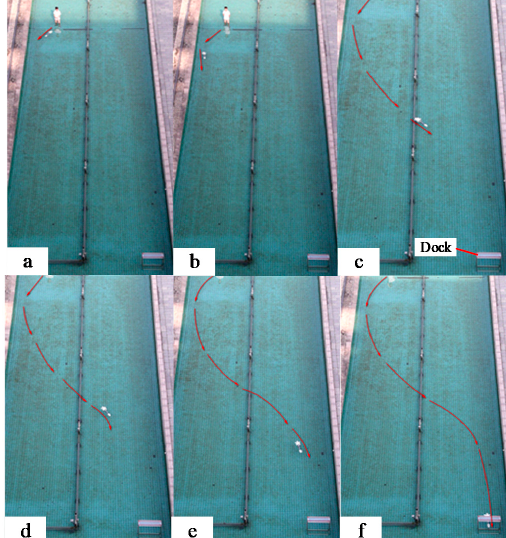
Table 2. Main vehicle specifications of the test bed AUV